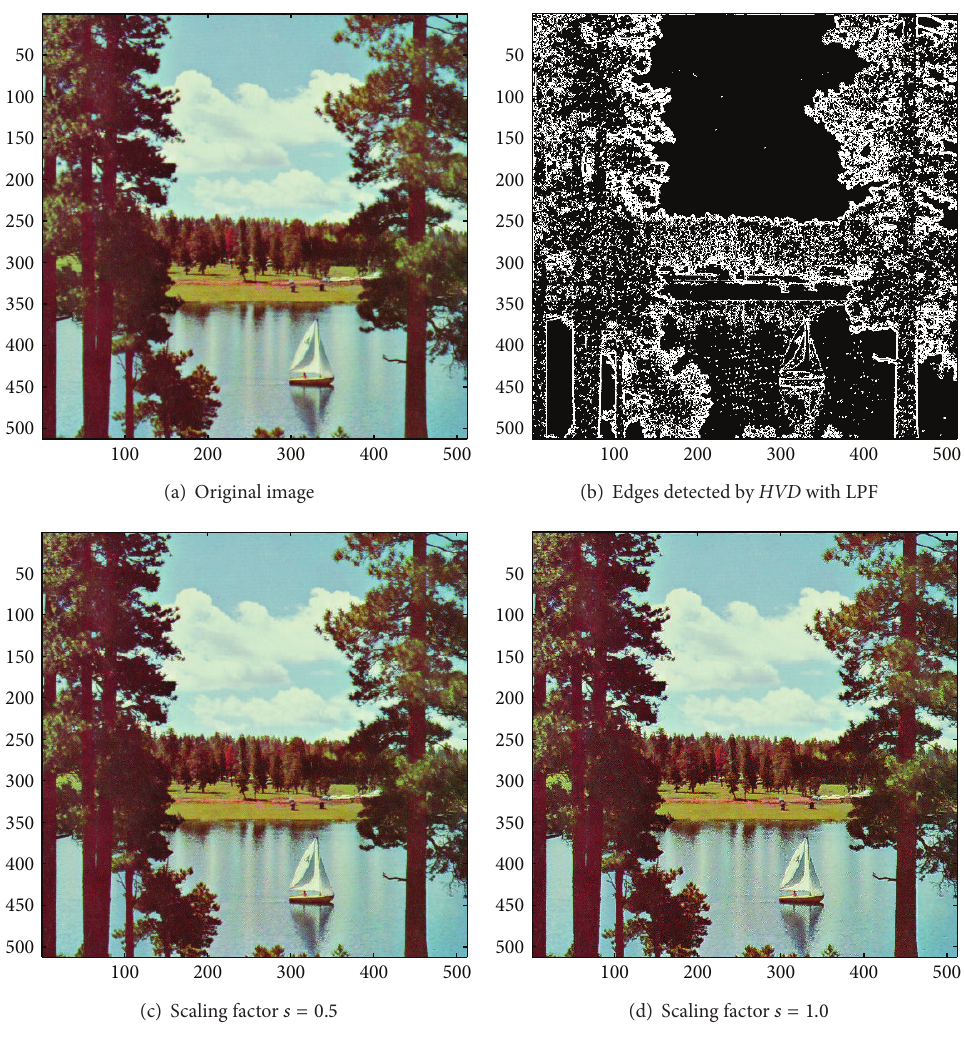
= 16 for HVD . (a) The image “Sailboat on lake” (512 × 512 color image). (b) Edges detected by HVD with LPF. (c and d) Figure 10: 𝜃 eth Sharpened results by HVD with scaling factors 0.5 and 1.0 ,